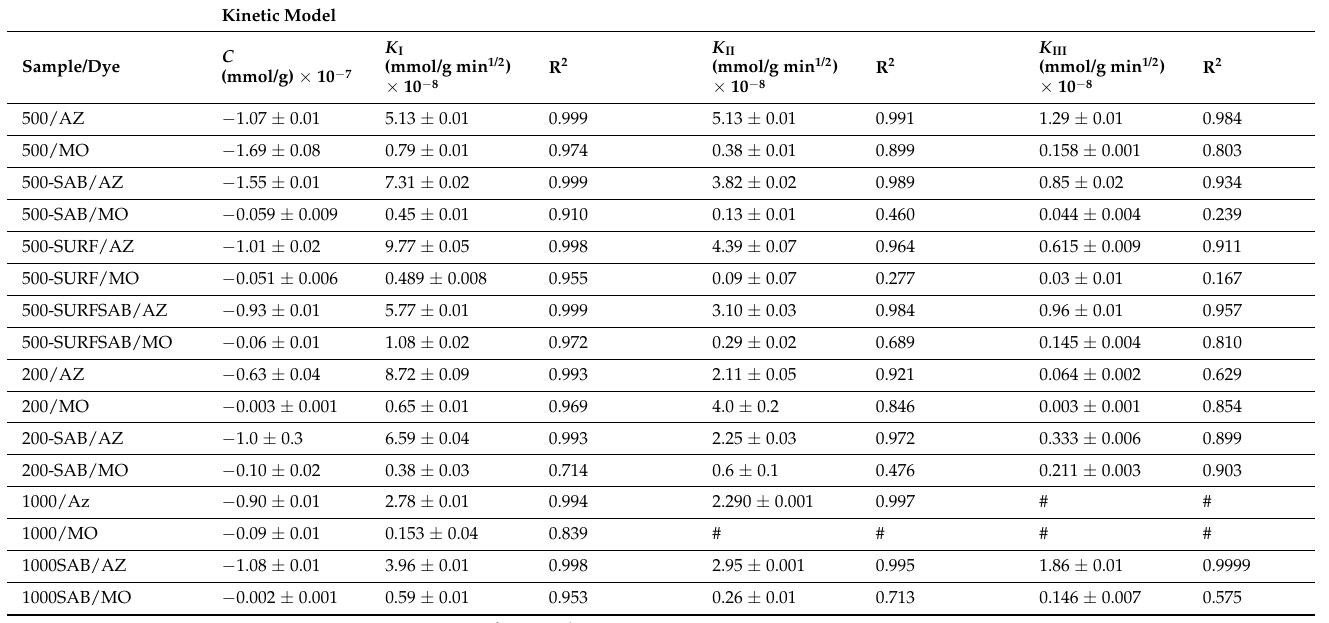
Table 5. Kinetic parameters of the intraparticle diffusion model for the adsorption of AZ and MO onto the